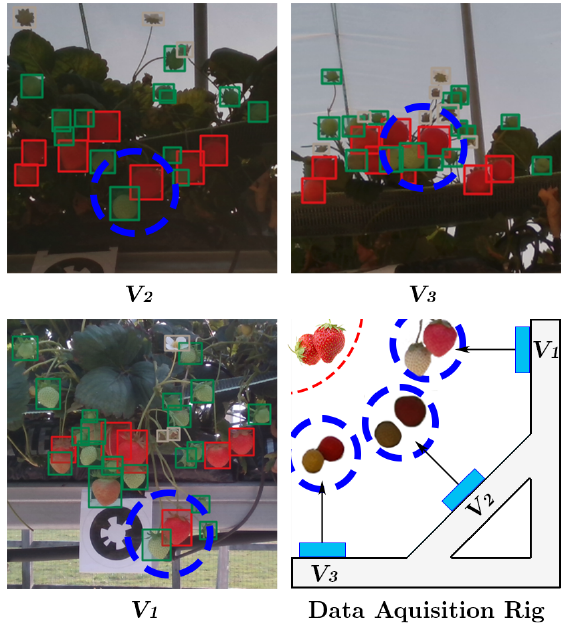
Figure 2. View point illumination variance for V 1 , V 2 and V 3 . Blue circles show the effect viewpoint has on class